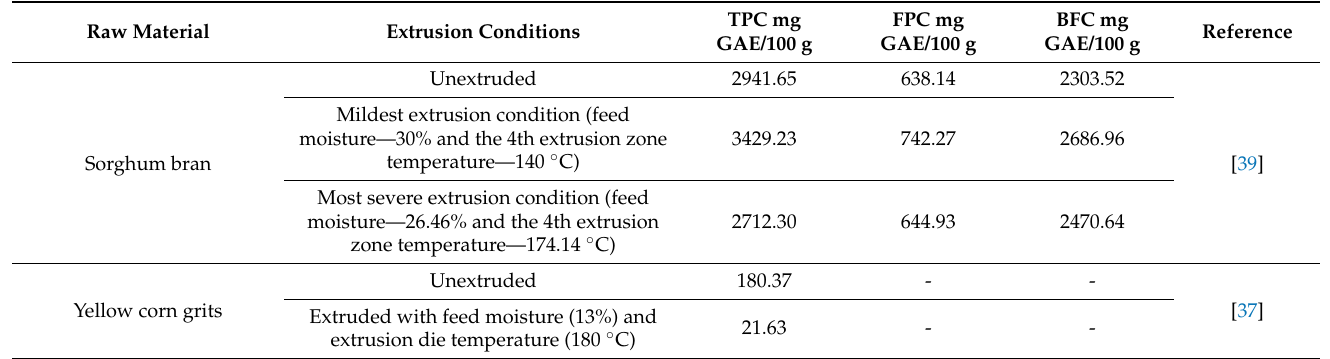
Table 1. Total phenolic compounds (TPC), free phenolic compounds (FPC), and bound phenolic compounds (BPC) from raw material and extrudates from some cereals and pseudocereals under different feed moisture and extruder